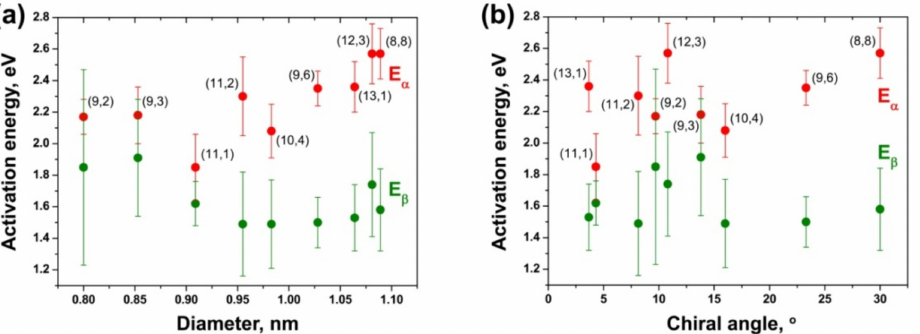
Figure 15. The activation energies E α and E β of the growth of the inner tubes with the chiralities of (8,8), (12,3), (13,1), (9,6), (10,4), (11,2), (11,1), (9,3) and (9,2) upon in situ annealing of the nickelocene- filled SWCNTs plotted versus the tube diameter ( a ) and chiral angle ( b ). The chiralities of inner tubes are denoted near the corresponding